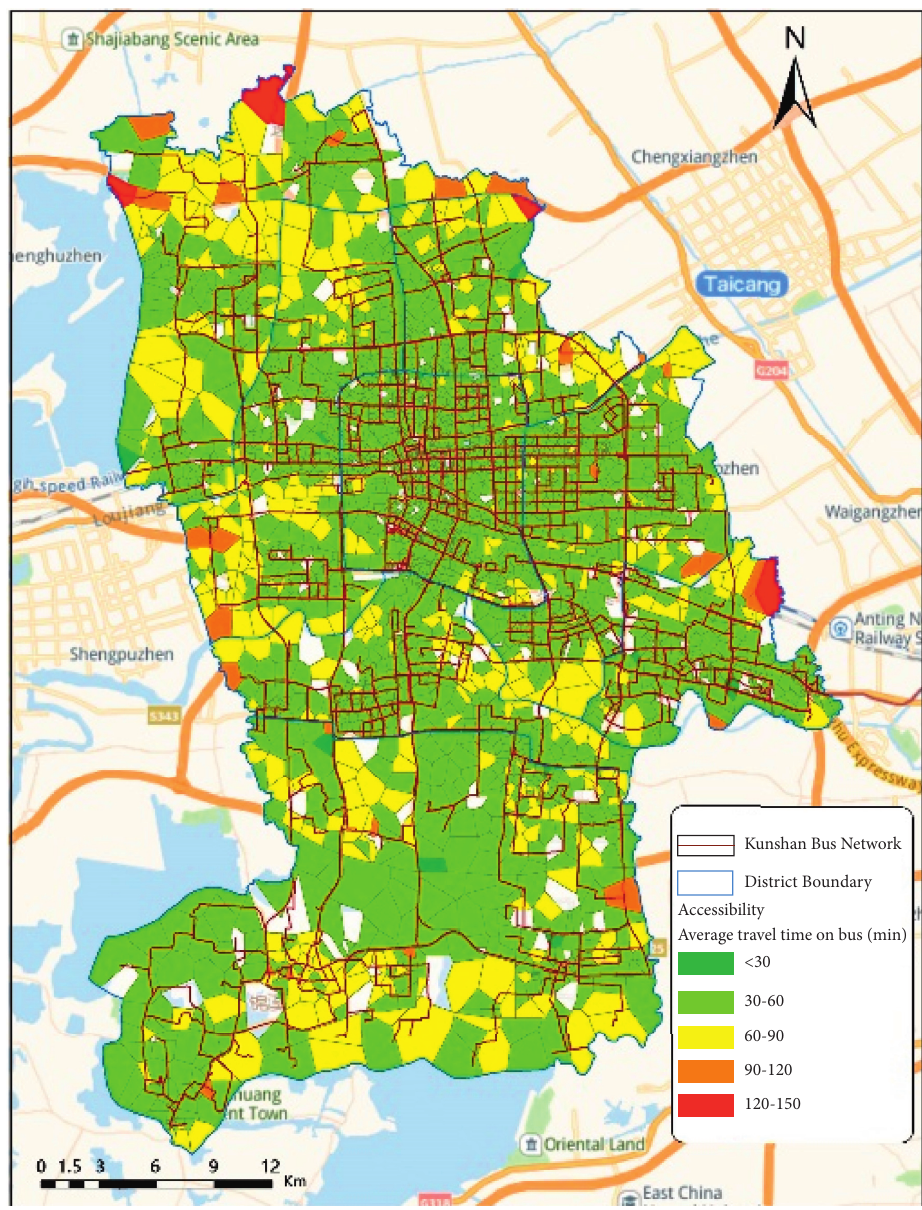
Figure 2: Public transport